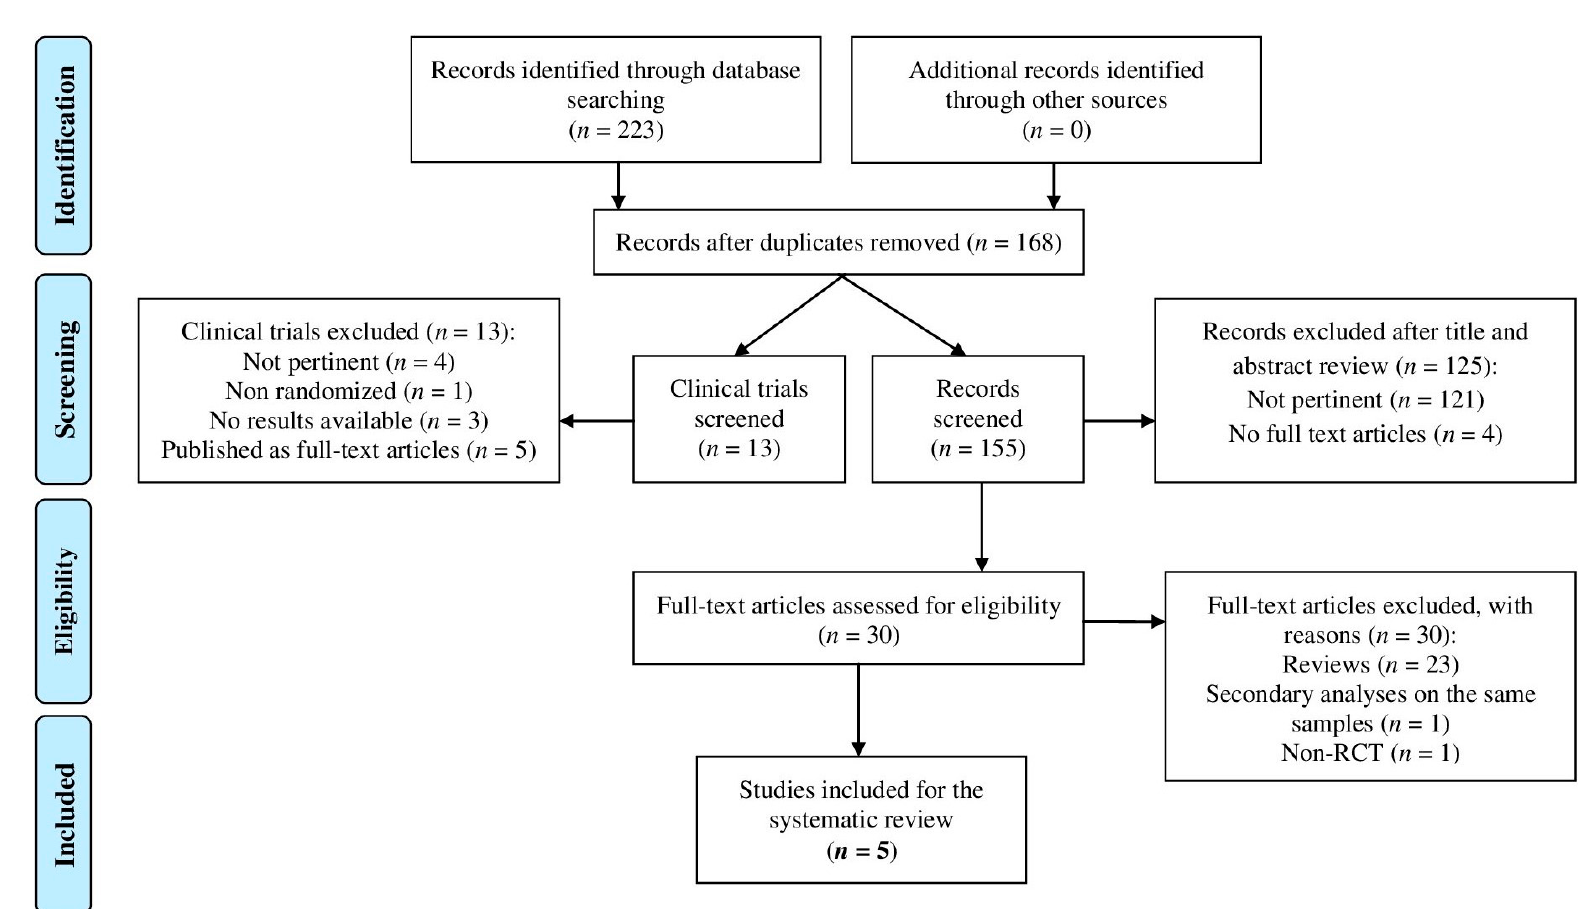
Figure 1. PRISMA flow diagram of study selection process.